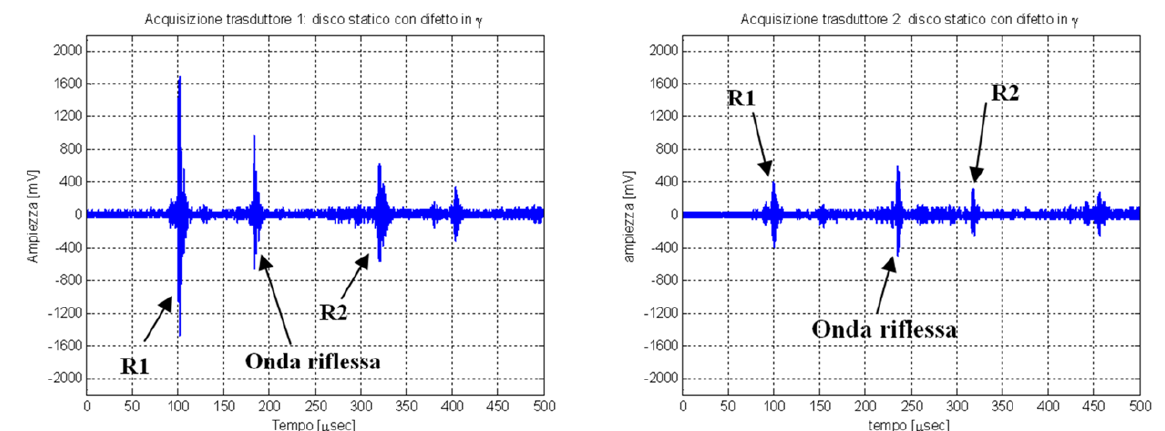
Figura 5: Segnale acquisito dal trasduttore 2. Disco fermo con difetto in γ =-70°. Figura 5: Signal acquired by transducer 2. Static disk with defect at γ